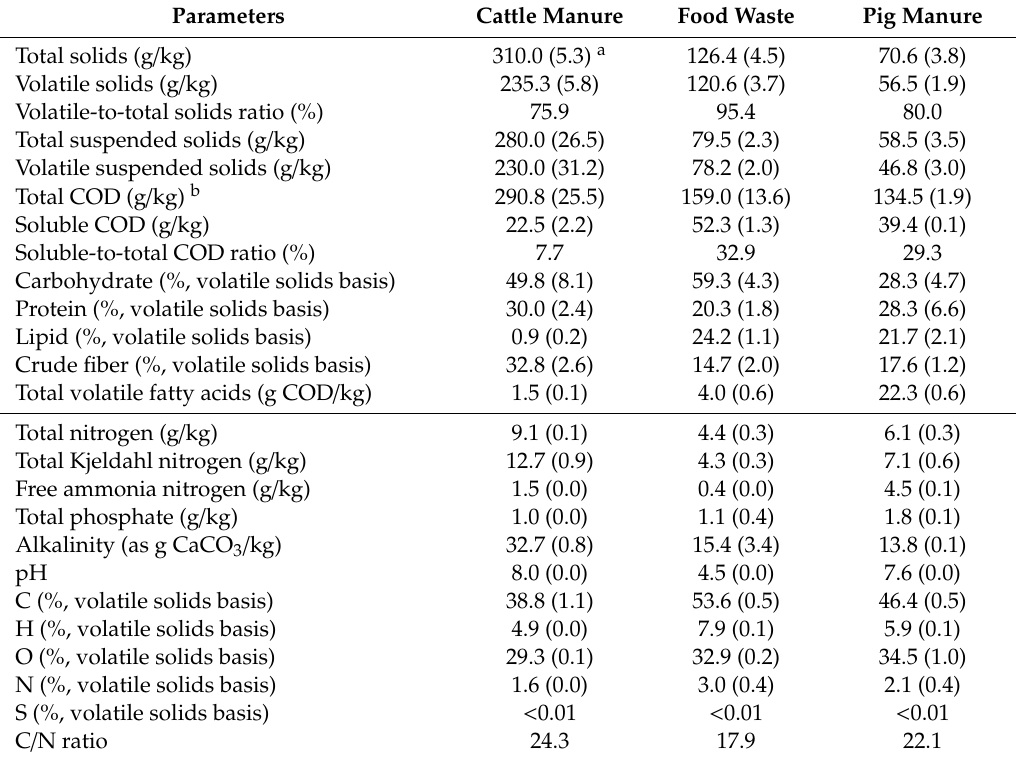
Table 1. Physiochemical characteristics of the substrates used in this study. Parameters Cattle Manure Food Waste Pig